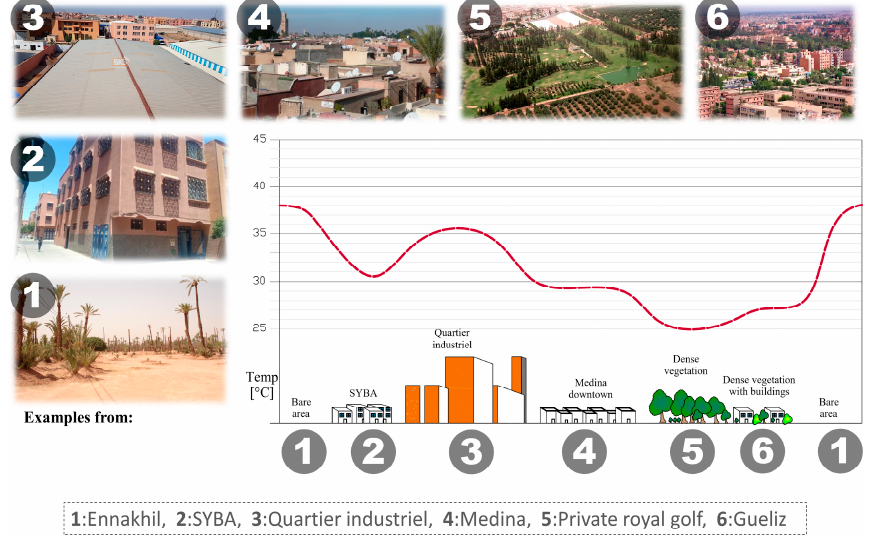
Figure 16. Summary of the spatial variation in LST in the city during the daytime.